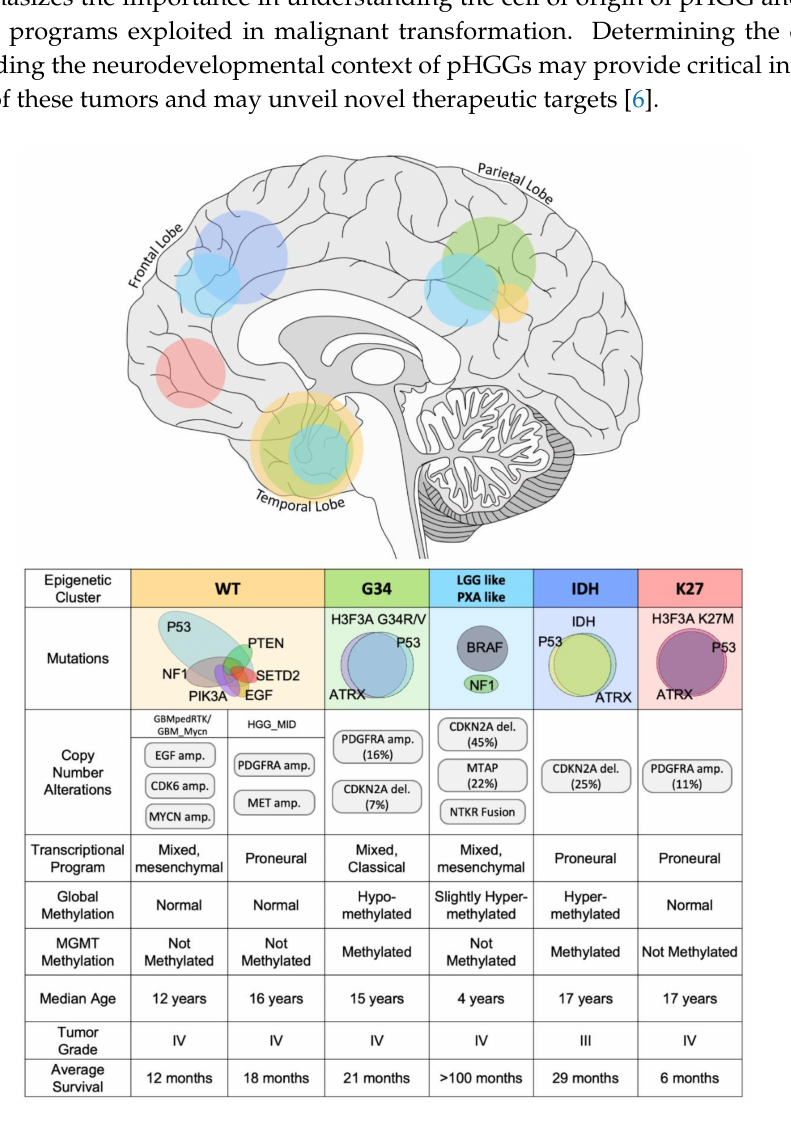
Figure 3. Scheme depicting the molecular classification of hemispherical pHGG, indicating the main molecular subgroups and the common mutations, genetic alterations, transcriptional programs, global, and O-6-Methylguanine-DNA Methyltransferase (MGMT) methylation status, and the clinical characteristics (included anatomical location in the upper brain illustration) associated to each molecular